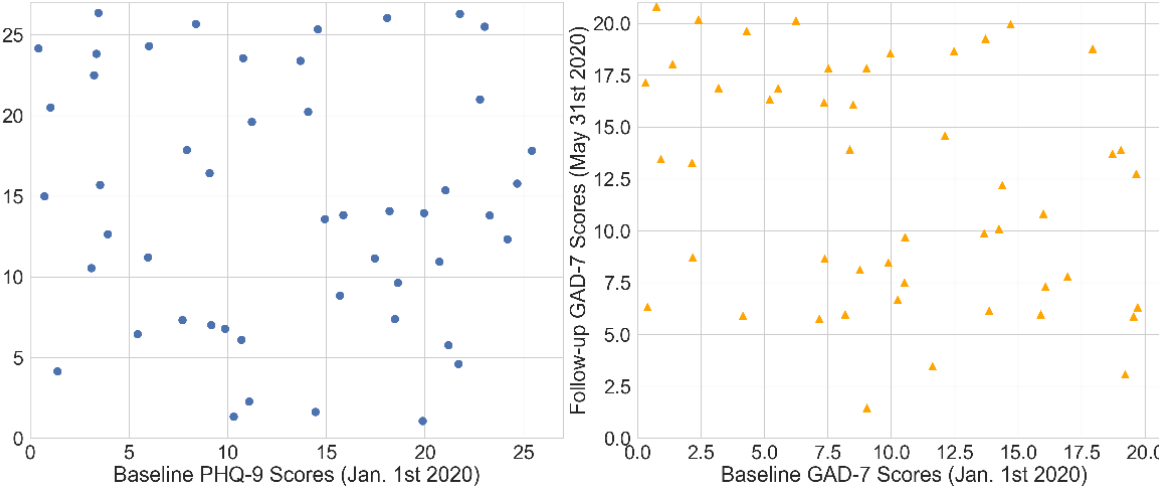
Figure 4. The distributions of PHQ-9 depression and GAD-7 anxiety scores before and after the lockdown. The PHQ-9 scores are shown on the left, and the GAD-7 scores are shown on the right. GAD-7: General Anxiety Disorder-7; PHQ-9: Patient Health Questionnaire-9.